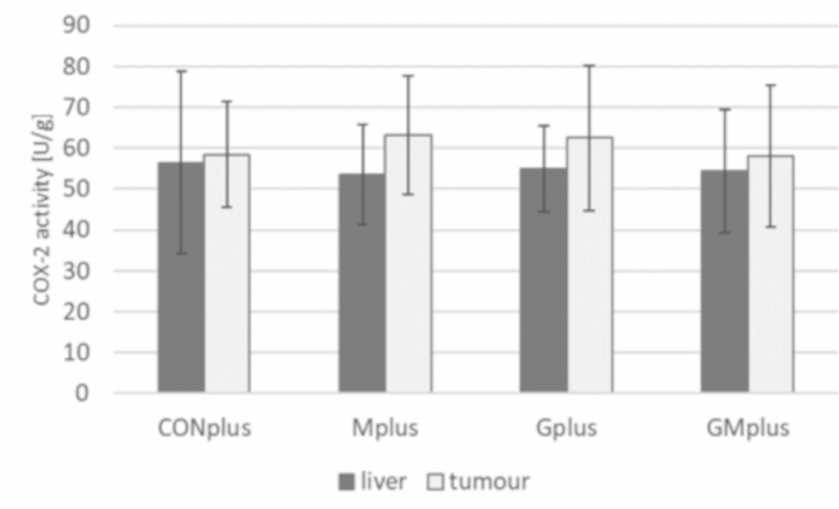
Figure A1. Cyclooxygenase (COX)-2 activity in livers and tumours of experimental